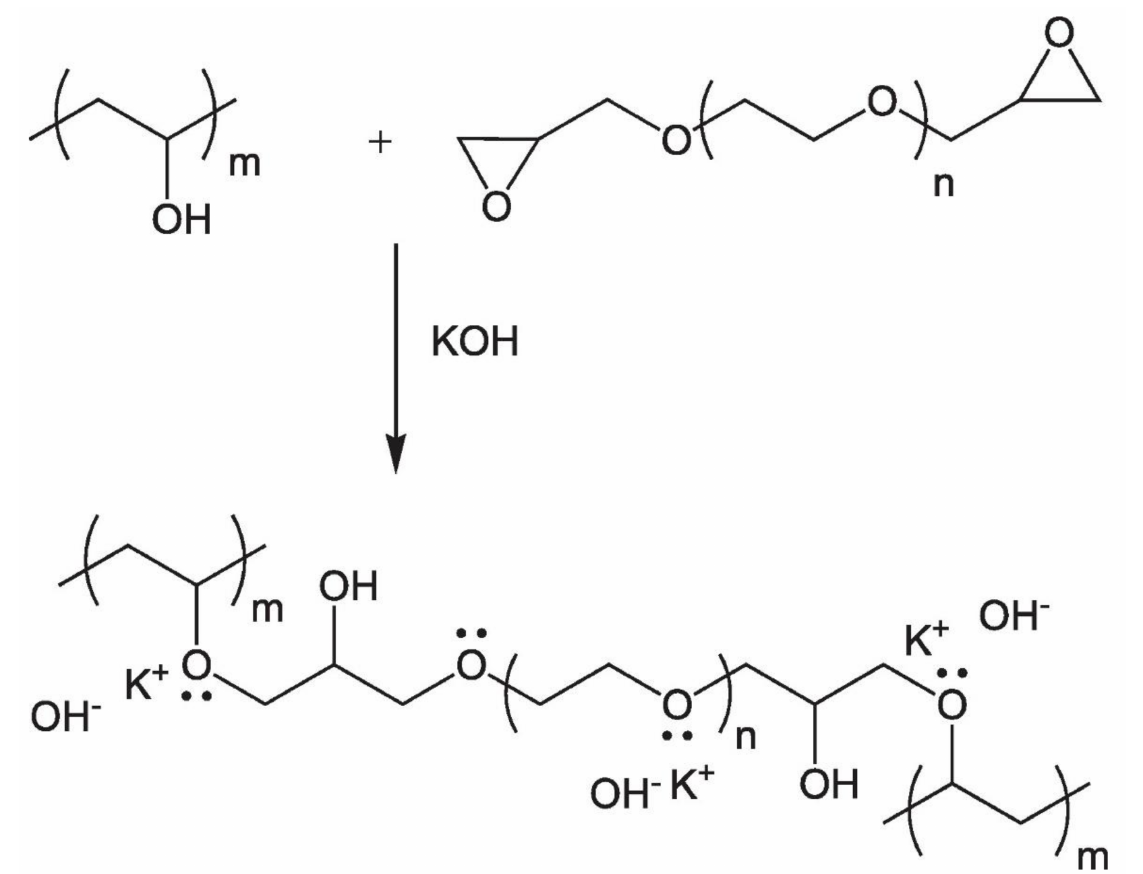
Figure 7. Schematic representation of the synthesis of the AEMs based on PVA, KOH, and PEGDGE (Reprinted with permission from ref. [115] Copyright 2012